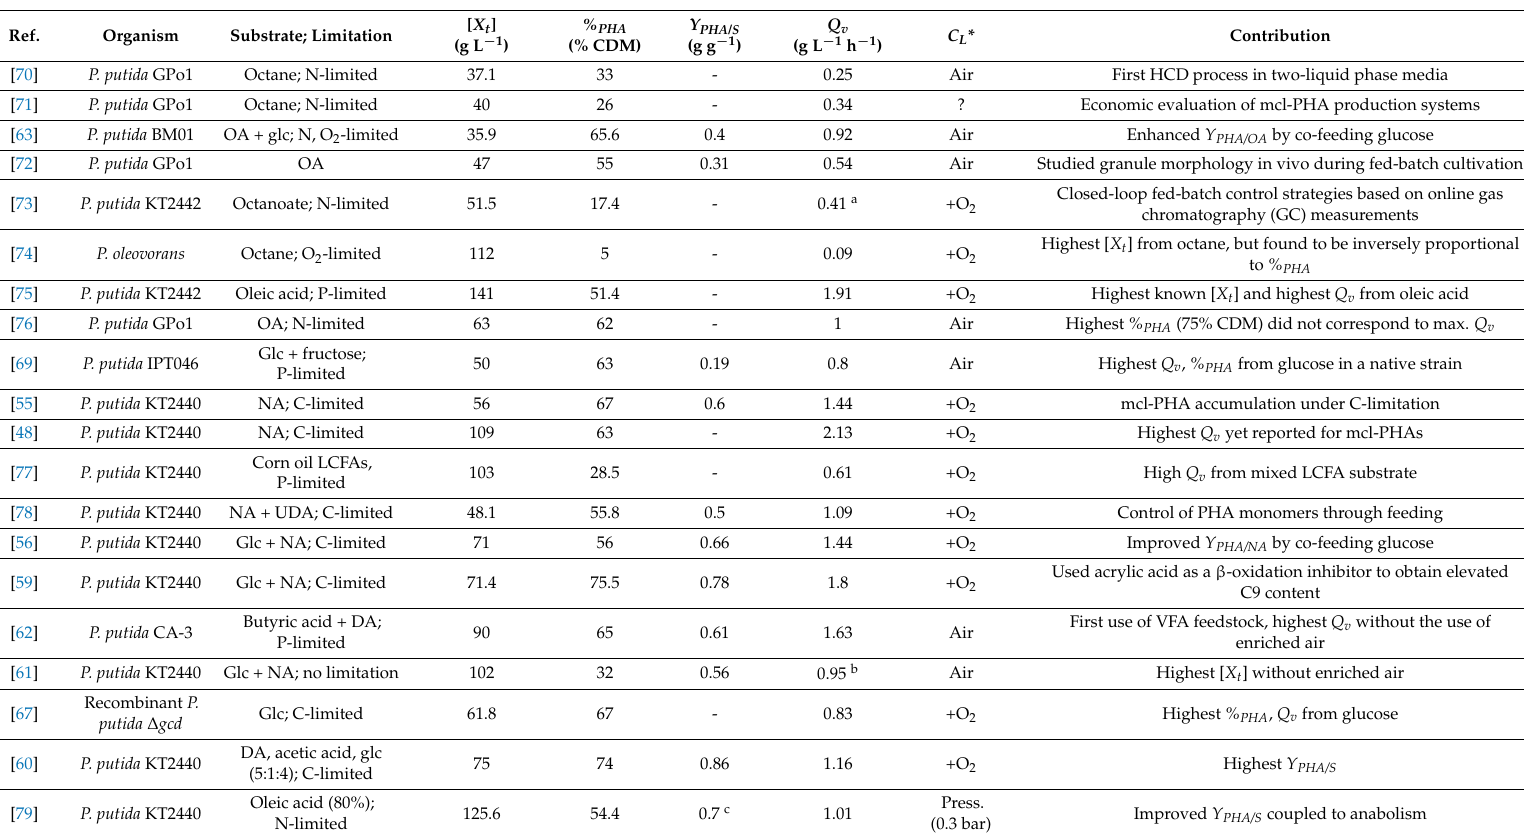
Table 1. Chronological summary of process developments for high-productivity fed-batch bioreactor systems in medium-chain length polyhydroxyalkanoate (mcl-PHA)